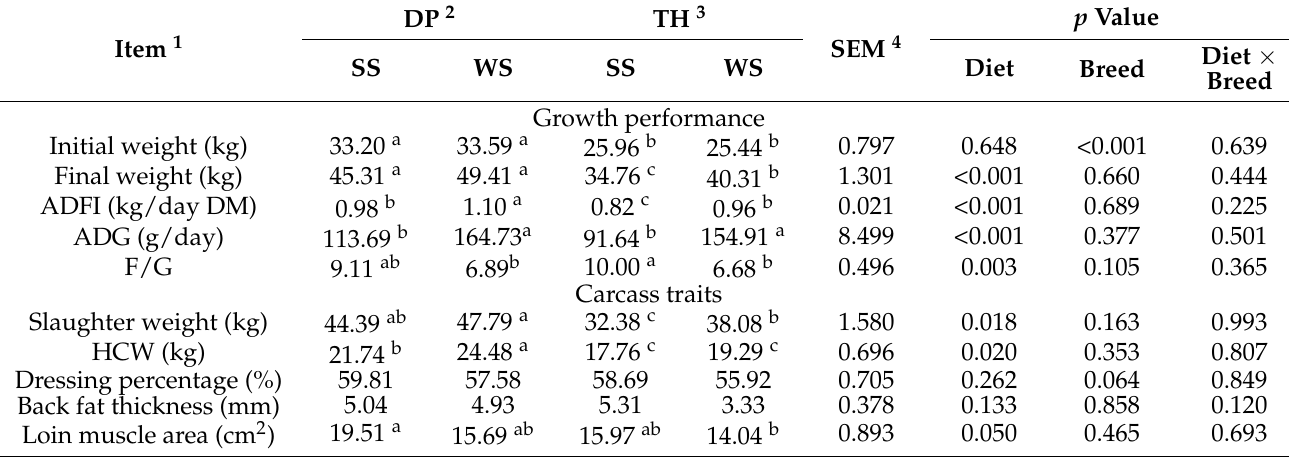
Table 3. Effect of silage diet and breed on growth performance and carcass traits of lambs ( n = 7 per group).